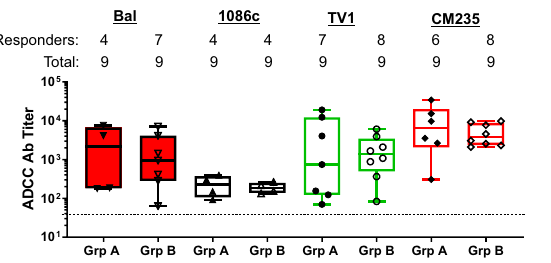
Fig. 7 Rate and magnitude of ADCC response against infectious molecular clone (IMC) infected target cells in DP6-001 volunteer sera. ADCC-Luc assay was used to detect ADCC against target cells infected with one of the four IMCs from HIV-1 clade B (Bal), C (1086c and TV1), and AE (CM235). The cut-off line is shown and the negative responders below the cut-off level were not included in the magnitude